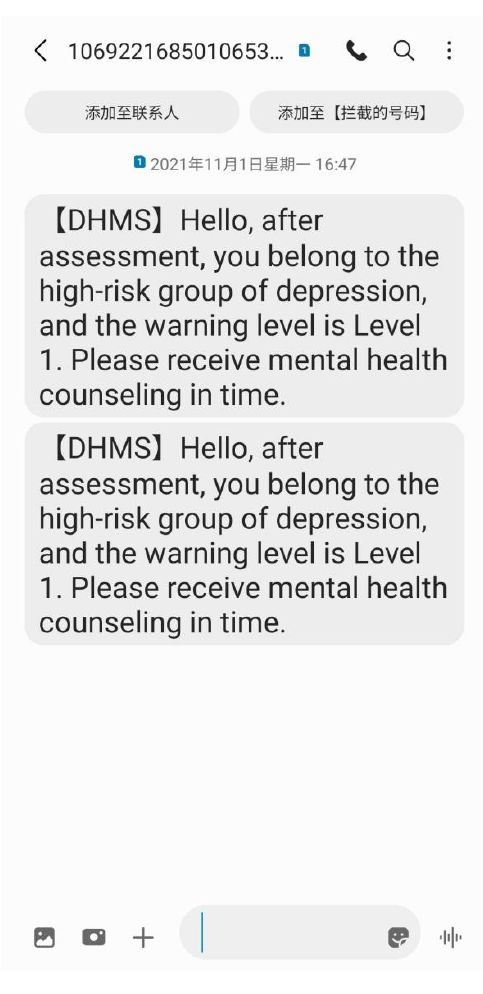
Figure 6. Warning information sent by the SMS